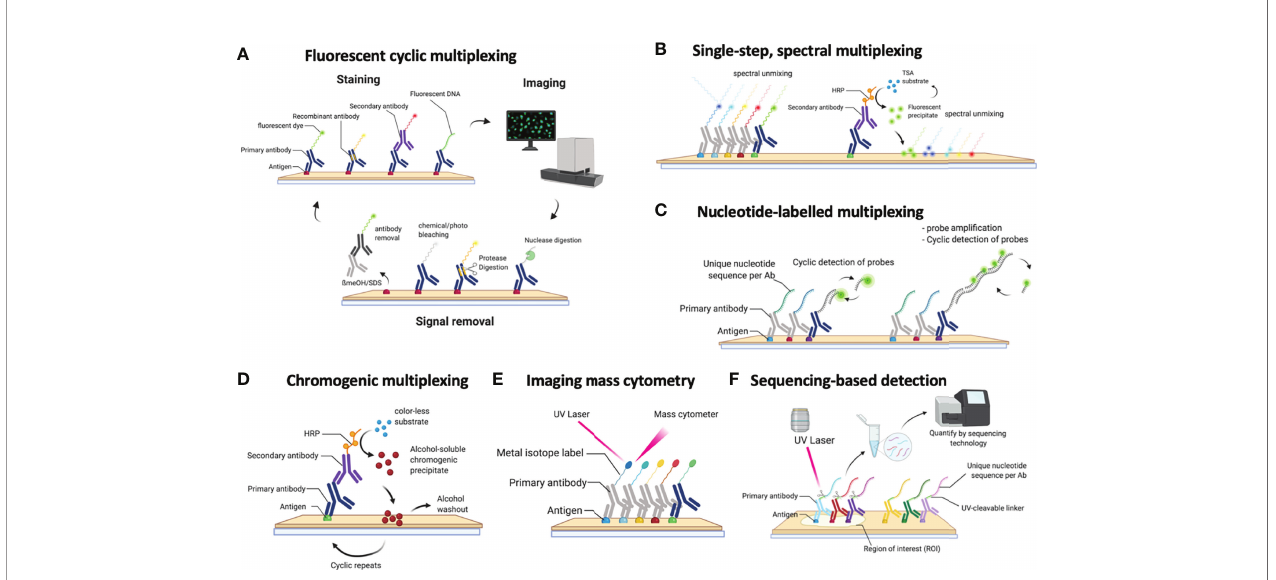
FIGURE 1 | Schematic overview of the currently available methods for multiplexed immunohistochemistry (IHC). (A) Currently, the most common approach for multiplexed IHC makes use of fl uorescently labelled probes, which are either directly coupled to the primary antibody or indirectly provided by a secondary antibody, that are detected in a cyclic fashion consisting of a staining protocol, followed by tissue imaging and signal removal. (B) In contrast to cyclic methods, single-step spectral methods detect all dyes in the tissue simultaneously: these can either be provided by directly labelled antibodies that are all simultaneously present in the tissue section or by the cyclic generation of TSA precipitates which are subsequently spectrally unmixed in a single imaging step. (C) Antibodies can also be detected by covalently linked nucleotide labels to which fl uorescently labelled probes are hybridized in a cyclic fashion for which each cycle gets imaged. (D) Non- fl uorescent mIHC methods involve the cyclic generation of chromogenic substrates that are washed away following an imaging step in between each cycle. (E) For imaging mass cytometry (IMC), antibodies are labelled with metal isotopes which are detected by the local vaporization of the metal ions by a UV laser, following which the present isotopes are resolved using atomic spectrometry. (F) Finally, nucleotide labelled antibodies can be detected by removing the nucleotide labels from the antibodies using a laser beam, following which the nucleotides that were collected from a precise region of interest are sequenced to quantify the amount of available proteins in that